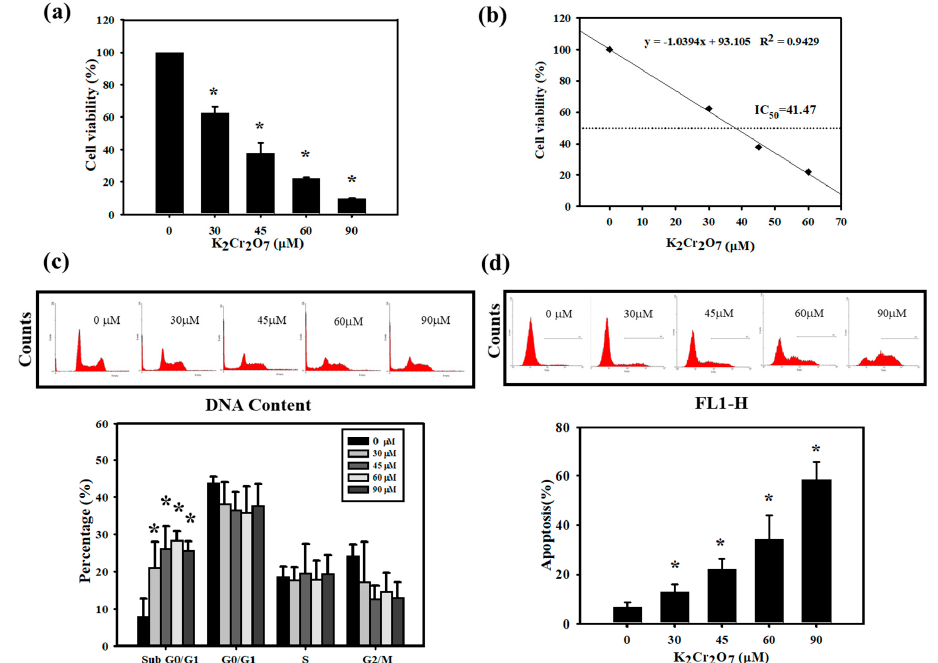
Figure 4. Measurement of cell viability, cell cycle distribution and apoptosis of Cr(VI) in HaCaT cells.